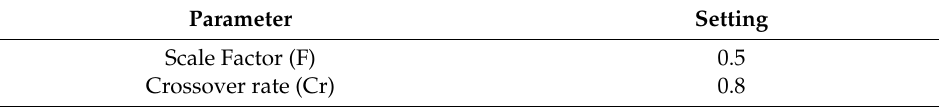
Table 3. Parameter setting for